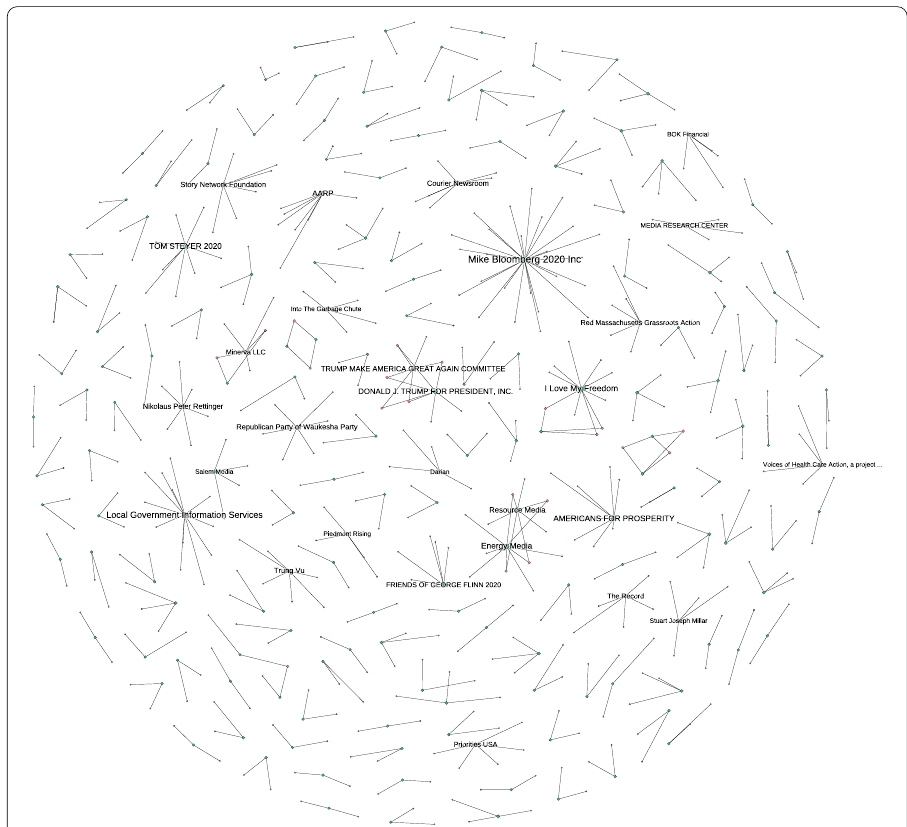
Fig. 1 A bipartite network connecting each sponsor (green) with all the Facebook pages (pink) on which it sponsored at least one political ad. Node size and label size are according to degree. The network only visualizes sponsors who post ads on at least two Facebook pages—that is, no dyads are